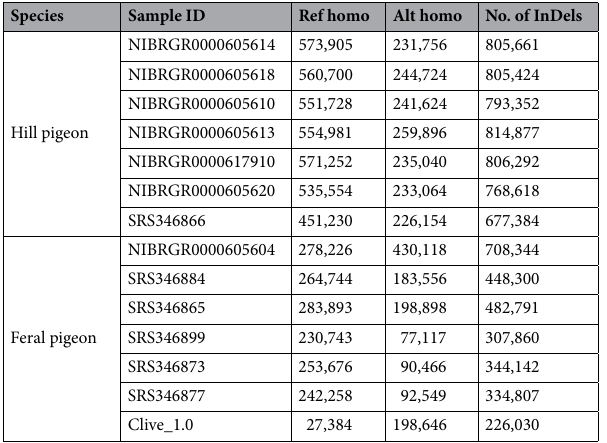
Table 2. InDel polymorphisms identified in the genome sequences of seven hill pigeons and seven feral/ domestic pigeons. Ref homo a relationship that is homozygous with the reference (feral pigeon) group, Alt homo a relationship that is homozygous with the alteration (hill pigeon) group.